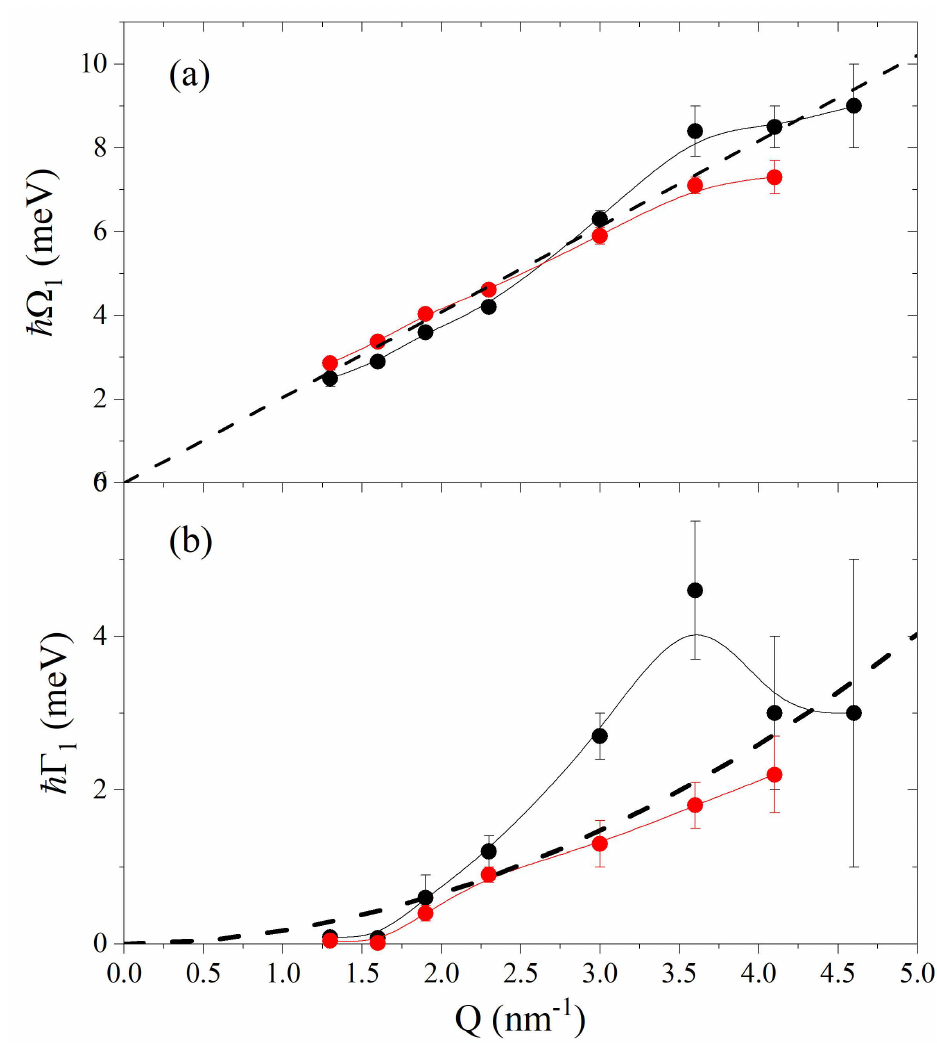
Figure 4. Panel ( a ): the Q –dependence of the undamped frequency, Ω 1 , of the DHO model profile (see text) is reported as obtained from the best–fitting of IXS spectra of the Au–NP suspension in glycerol (black dots) and pure glycerol (red dots). The solid line through experimental values are splines serving as guides to the eye. The linear dispersion expected in the elastic regime c inf Q is also reported (dashed black line) for reference, as derived using the elastic, or infinite frequency, sound velocity c inf reported in Ref. [27]. Panel ( b ): the corresponding best–fit values of the DHO half–width Γ 1 are reported with the same symbol together with the quadratic Q dependence (black dashed line) as derived from Ref.